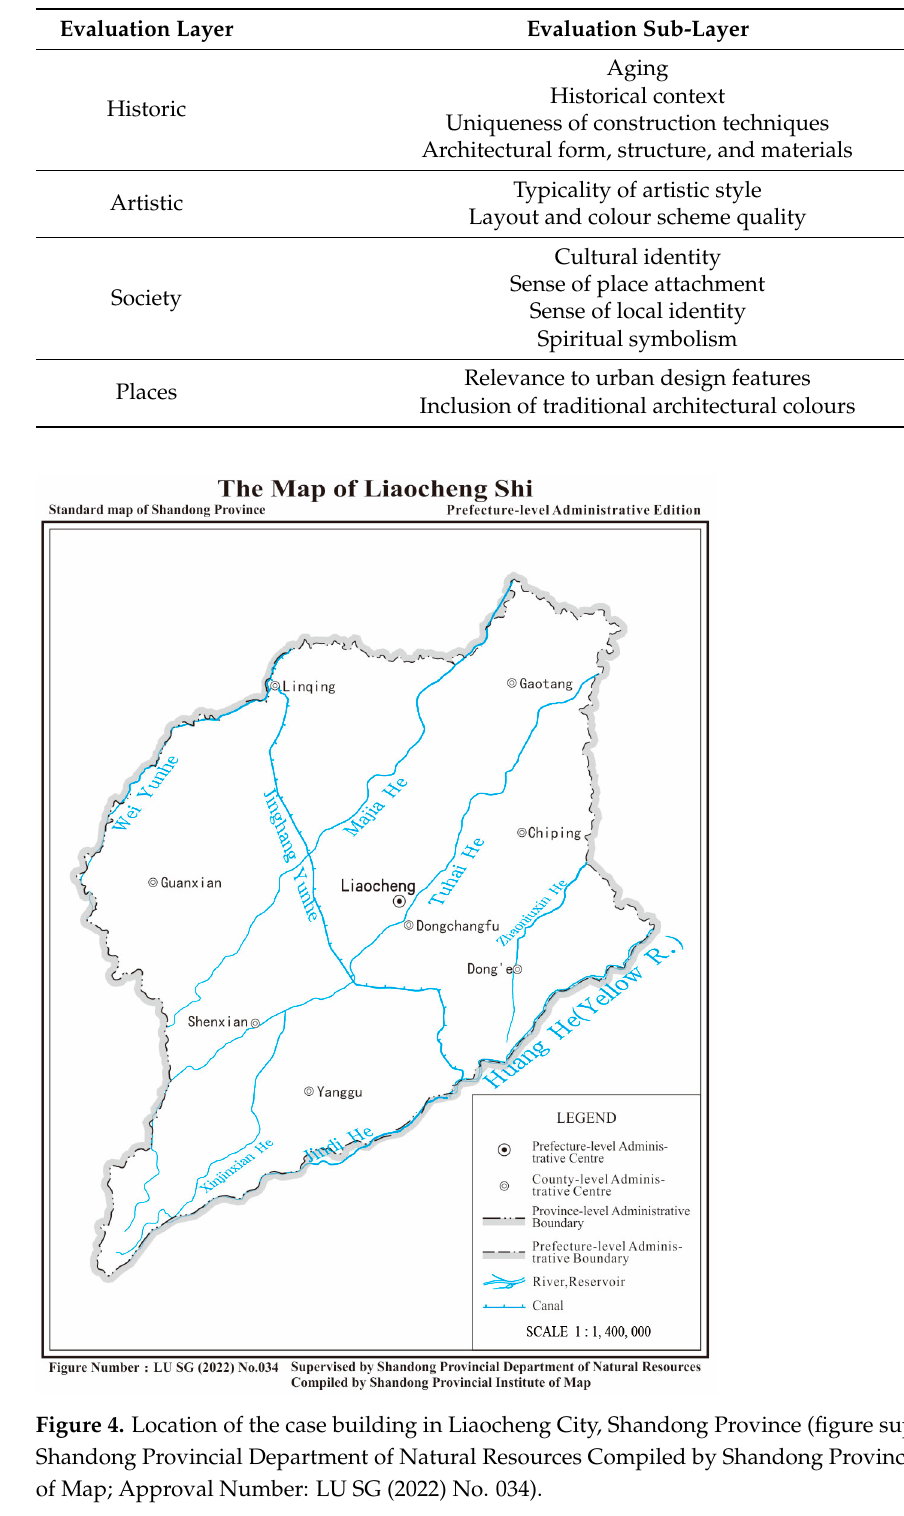
Table 3. Confucian architecture (Courtyard) selection criteria.